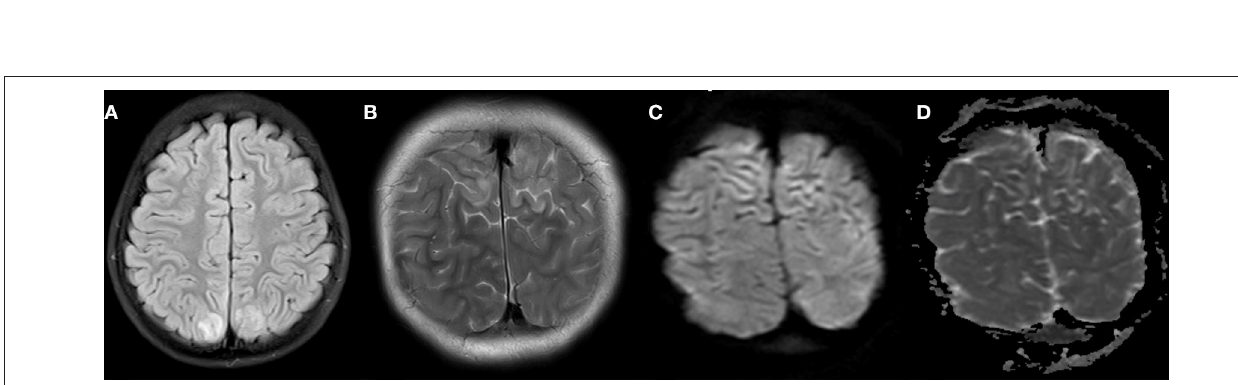
Frontiers in Neurology | www.frontiersin.org